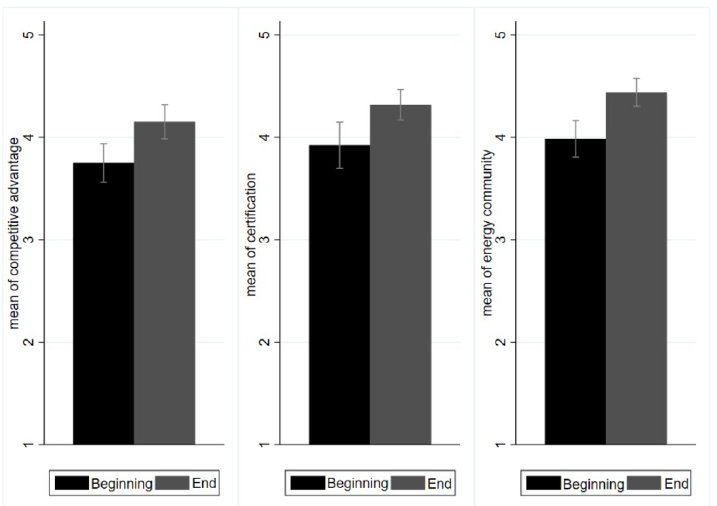
Figure 6. Mean values for the importance of energy communities, sustainable certifications and competitive advantage. Black bars represent values recorded at the beginning of the course and grey bars represent values recorded at the end of the course. Values range from 1 to 5, according to the Likert